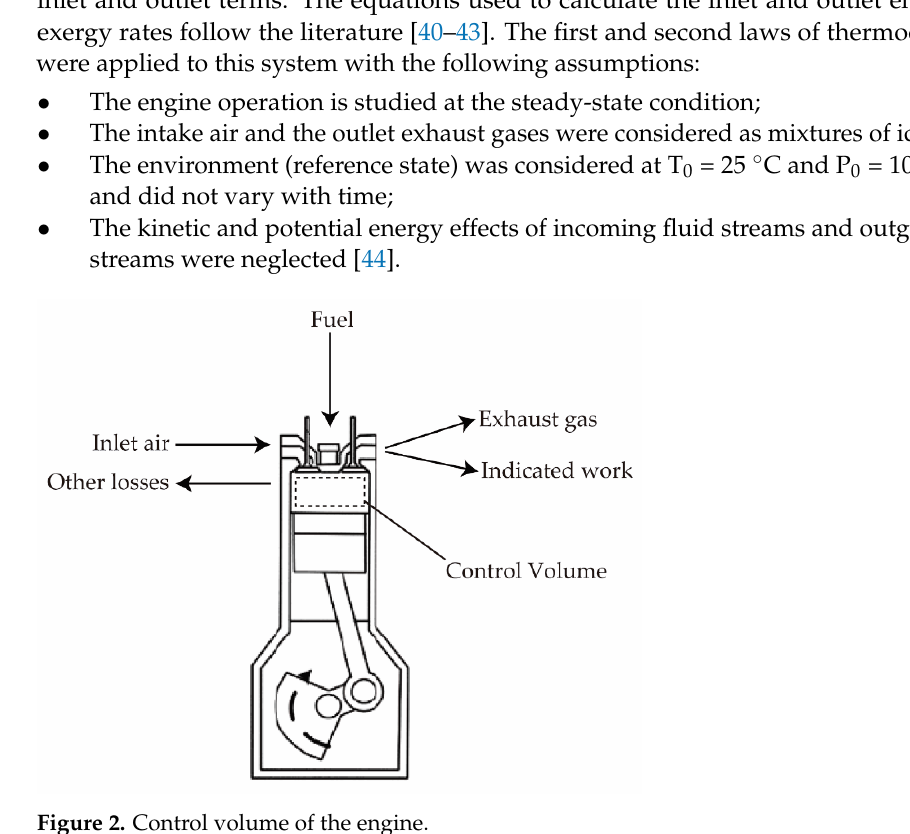
Figure 2. Control volume of the engine.